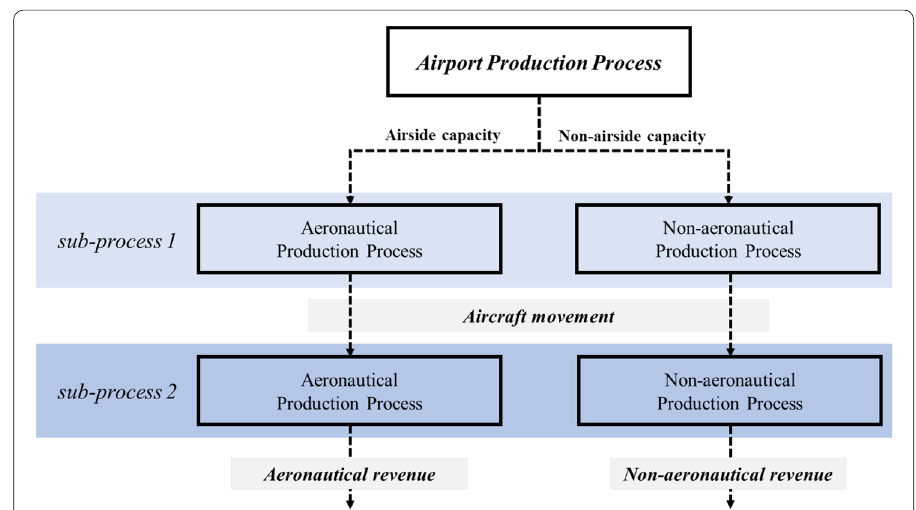
Fig. 1 Framework for airport production process. Airport production process has two input factors; airside capacity and non-airside capacity. And each process has sub-processes before and after aircraft movement. And after sub-processes, we can measure aeronautical and non-aeronautical revenue as output factors. With these input factors and output factors, we can measure the efficiency of aeronautical production process and non-aeronautical production